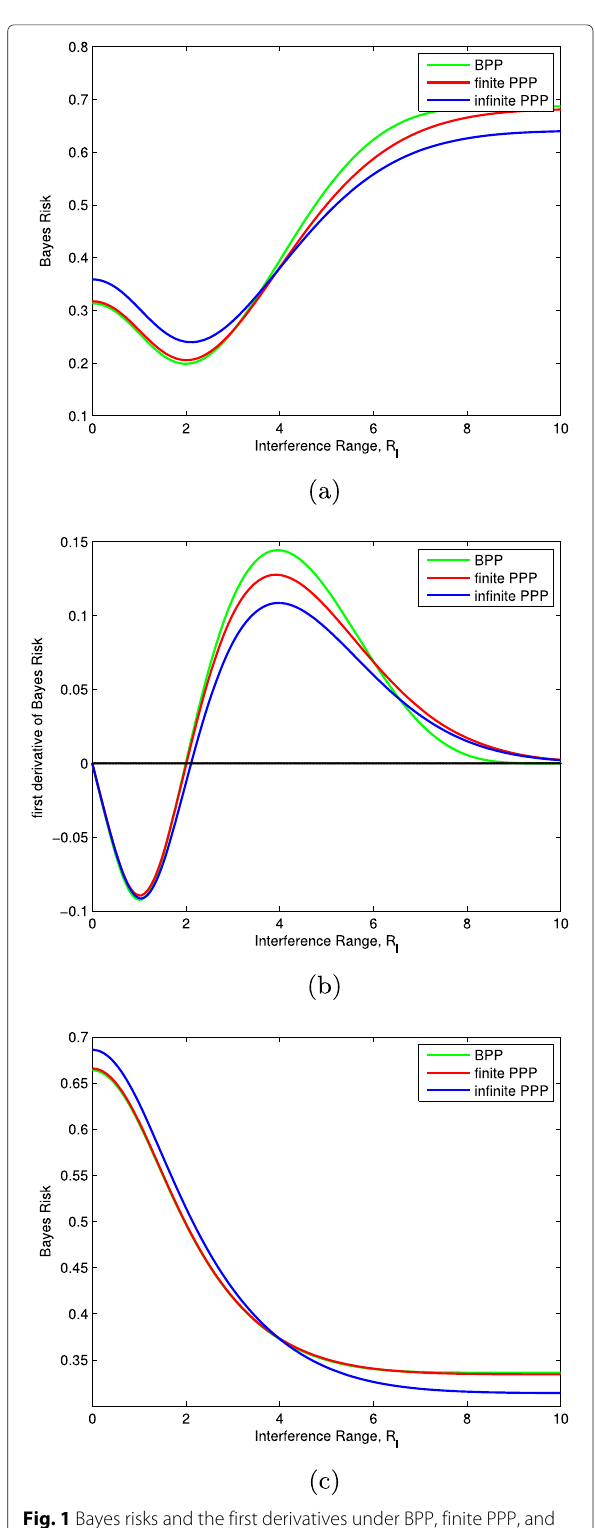
Fig. 1 Bayes risks and the first derivatives under BPP, finite PPP, and infinite PPP. a Bayes risks (SNR = + ∞ ). b The first derivatives of Bayes risks. c Bayes risks (SNR =